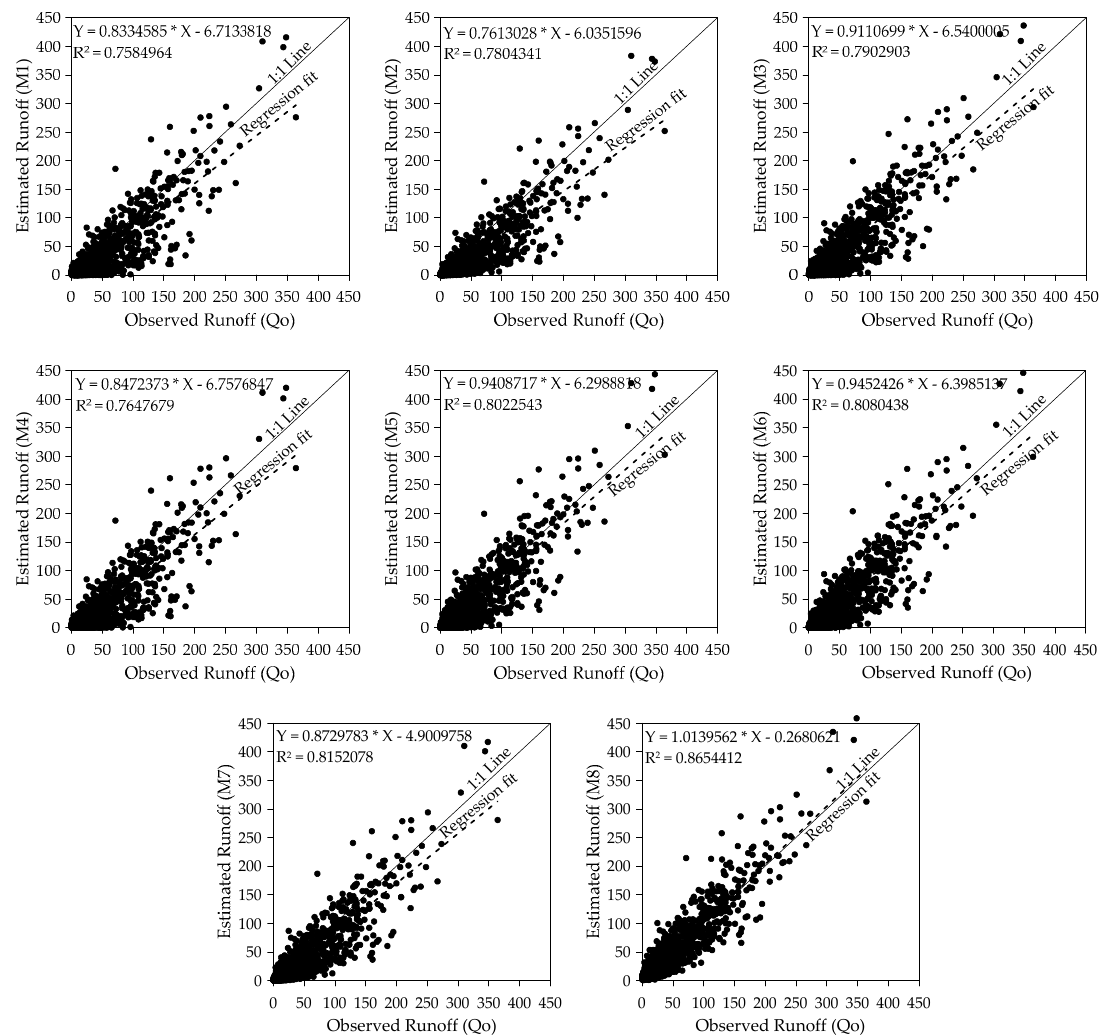
Figure 4. Observed and estimated runoff comparison for eight variants of the CN model using cumulative data of all 39 watersheds.